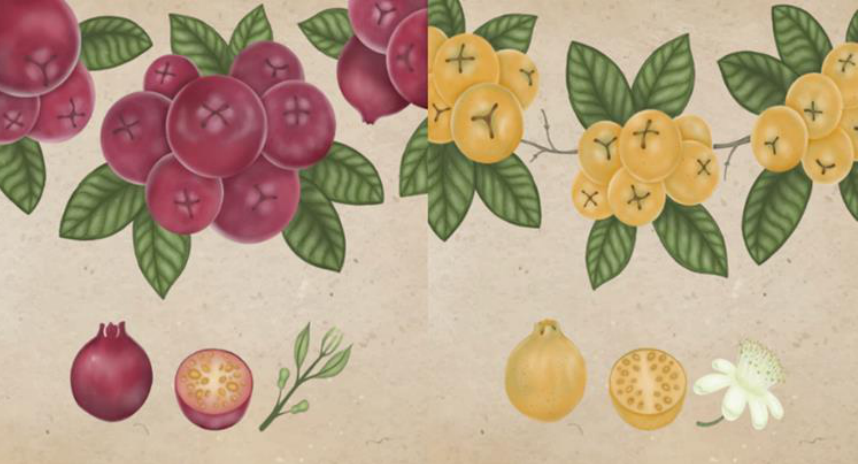
Figure 1. Red and yellow araçá ( P. cattleianum ). Illustration made by the Ribeiro, L.V. (2022).